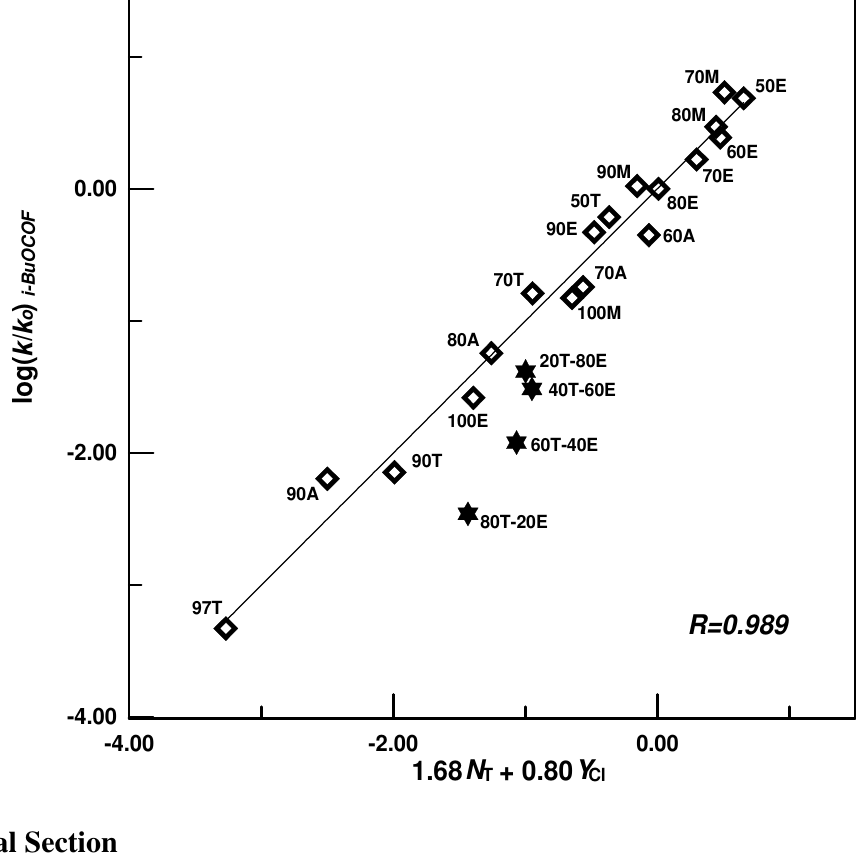
Figure 2. Plot of log ( k/k ) for solvolyses of isobutyl fluoroformate ( 1 ) at 40.0 °C against o (1.68 N + 0.80 Y ). The log ( k/k ) values for the four TFE-EtOH mixtures are not included o T Cl in the correlation; they are added to show their moderate deviation from the correlation